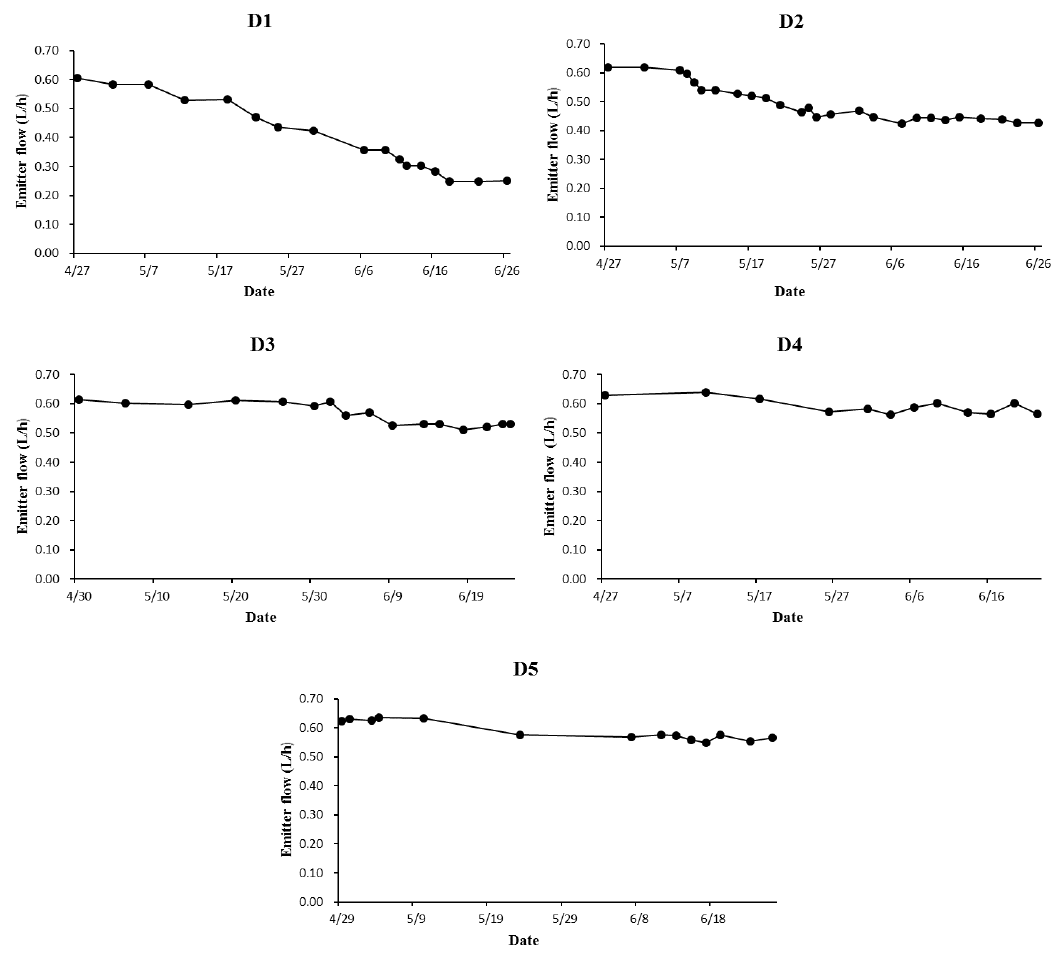
Figure 10. Emitter flow for different treatments.